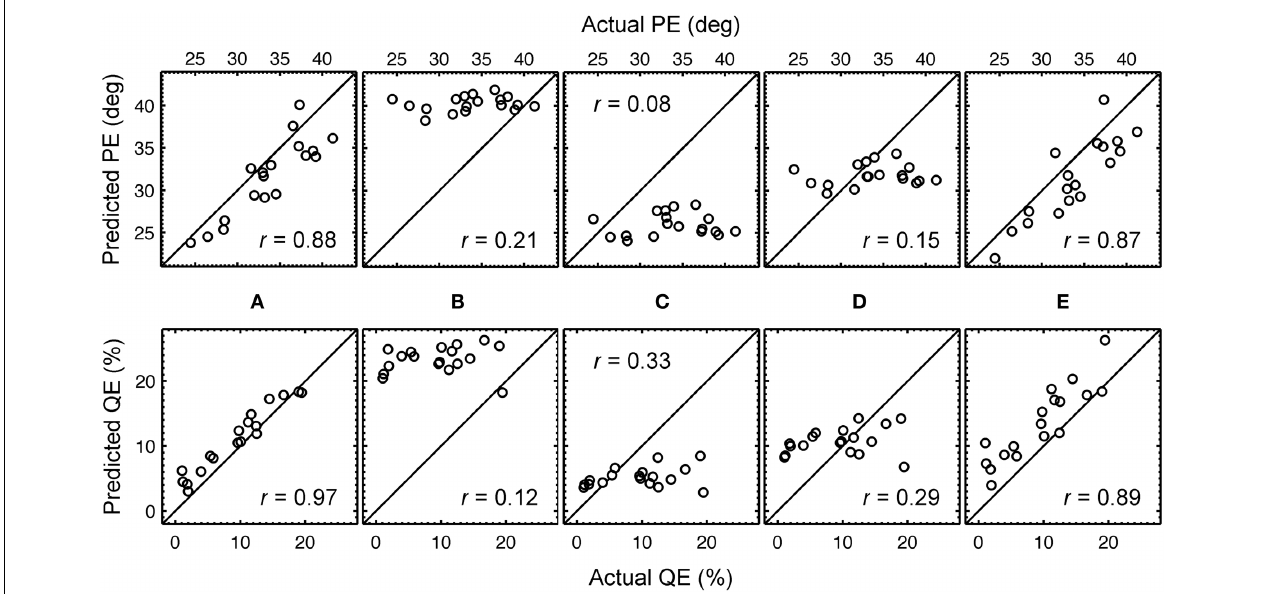
FIGURE 4 | Predicted versus actual localization performance. Predicted PEs and QEs are shown as functions of the actual PEs and QEs, respectively, for each listener. (A) Optimal listener-specific uncertainties U k . (B) Listener-constant uncertainty yielding best correlation for PE, U = 2 . 89. (C) Listener-constant uncertainty yielding